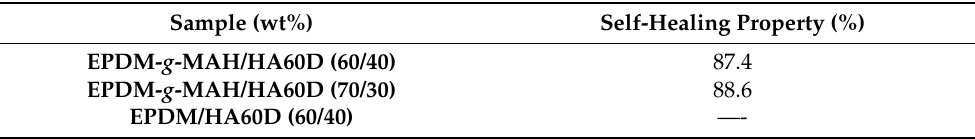
Table 3. The self-healing properties of EPDM- g -MAH/HA60D and EPDM/HA60D